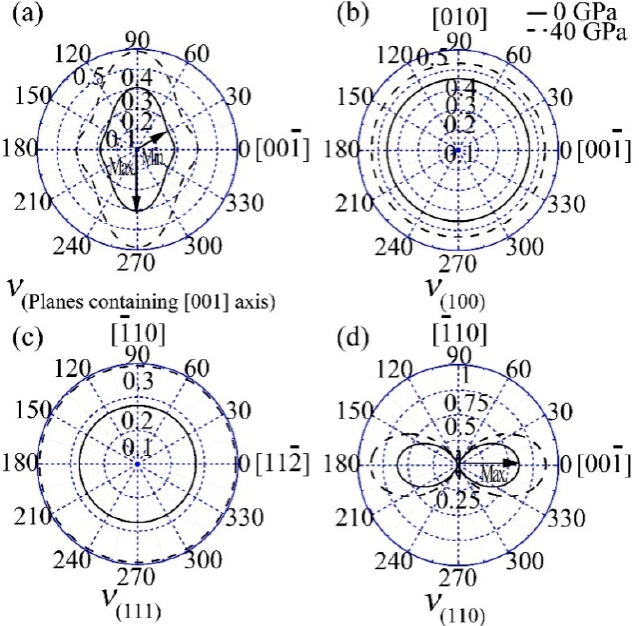
Figure 6. Direction dependences of the bulk moduli of: ( a ) wurtzite GaN, 0 GPa; ( b ) wurtzite GaN, 40 GPa; ( c ) zinc-blende GaN, 0 GPa; ( d ) zinc-blende GaN, 40 GPa.